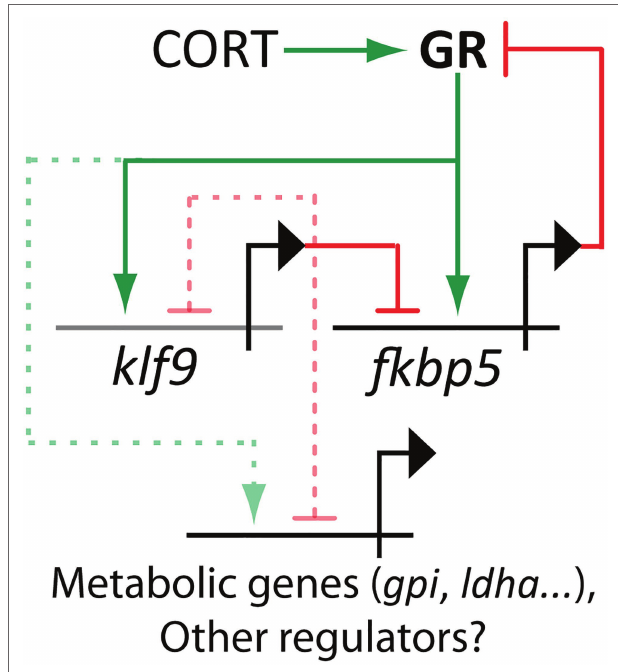
FIGURE 5 | Klf9 is a node in the glucocorticoid-responsive gene regulatory network mediating feedforward control of glucocorticoid responsivity ( via fkbp5 ) and metabolism. Activating interactions are depicted as arrows, inhibitory interactions as bars. Solid lines indicate established interactions, dashed lines are hypothesized (Gans et al., 2021 and unpublished